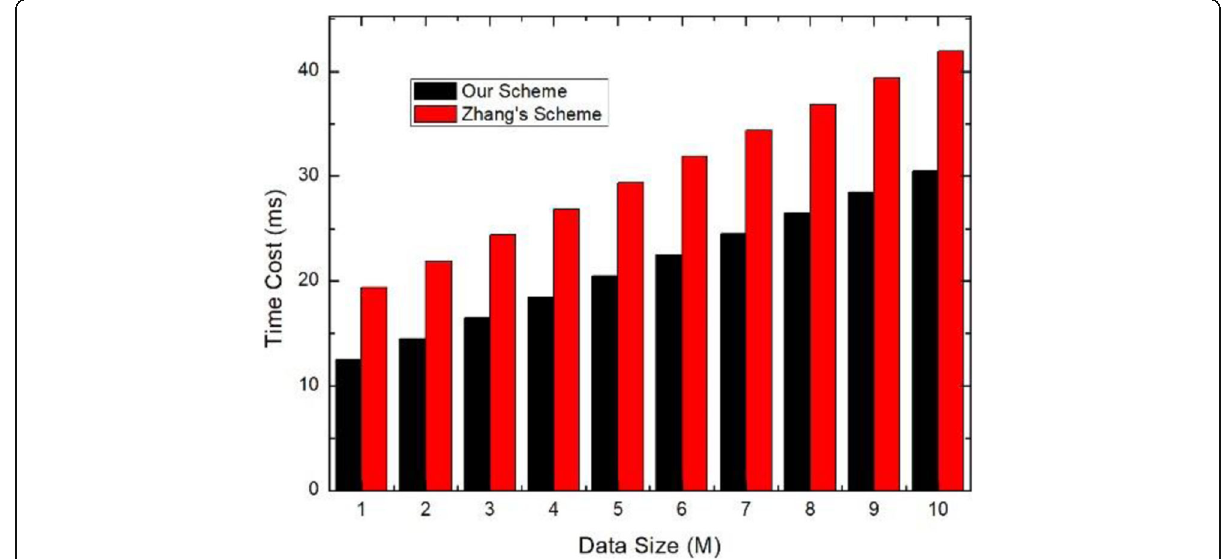
Fig. 9 Decryption Time of DR with Different Size of Shared